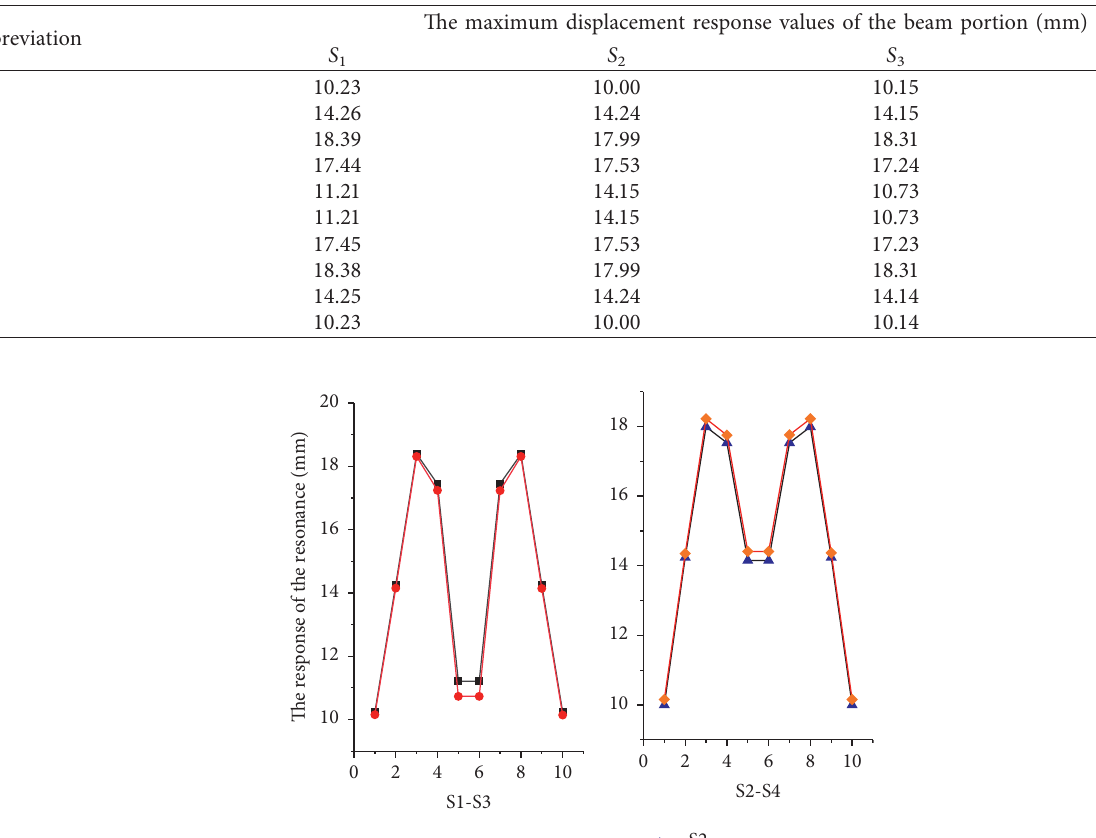
Figure 13: The response of the cable and beam in the C 4 ∼ C 6 subsystem under S 1 ∼ S 4 working conditions. (a) Under S 1 condition, the resonance response of the cable and beam in the C 4 ∼ C 6 subsystem. (b) Under S 2 condition, the resonance response of the cable and beam in the C 4 ∼ C 6 subsystem. (c) Under S 3 condition, the resonance response of the cable and beam in the C 4 ∼ C 6 subsystem. (d) Under S 4 condition, the resonance response of the cable and beam in the C 4 ∼ C 6 subsystem. Table 6: The maximum displacement values of the beam portion under various working conditions.